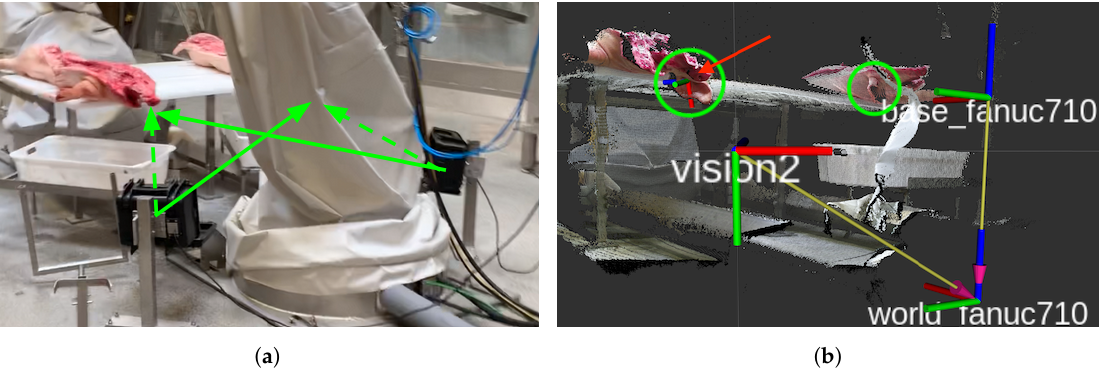
Figure 5. ( a ) Dual camera setup, one on each side of the robot. Highlighting the line of sight to ears from each camera. ( b ) Point of view of the left camera. Camera frame’s relative position to the world frame. Visible ears marked by green circles. Risk of occlusion from snout marked by a red